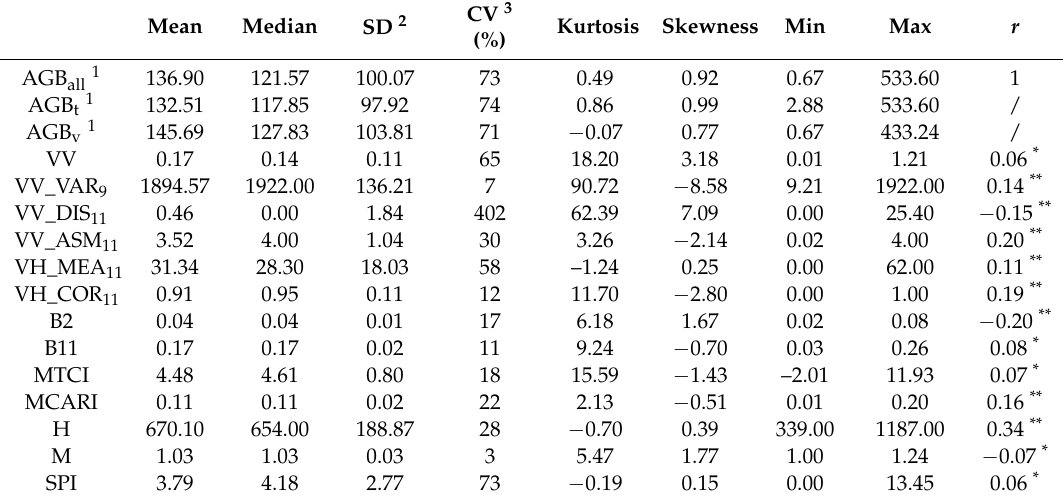
Table 3. Descriptive statistics of field-measured forest AGB, Sentinel-based, and topographical